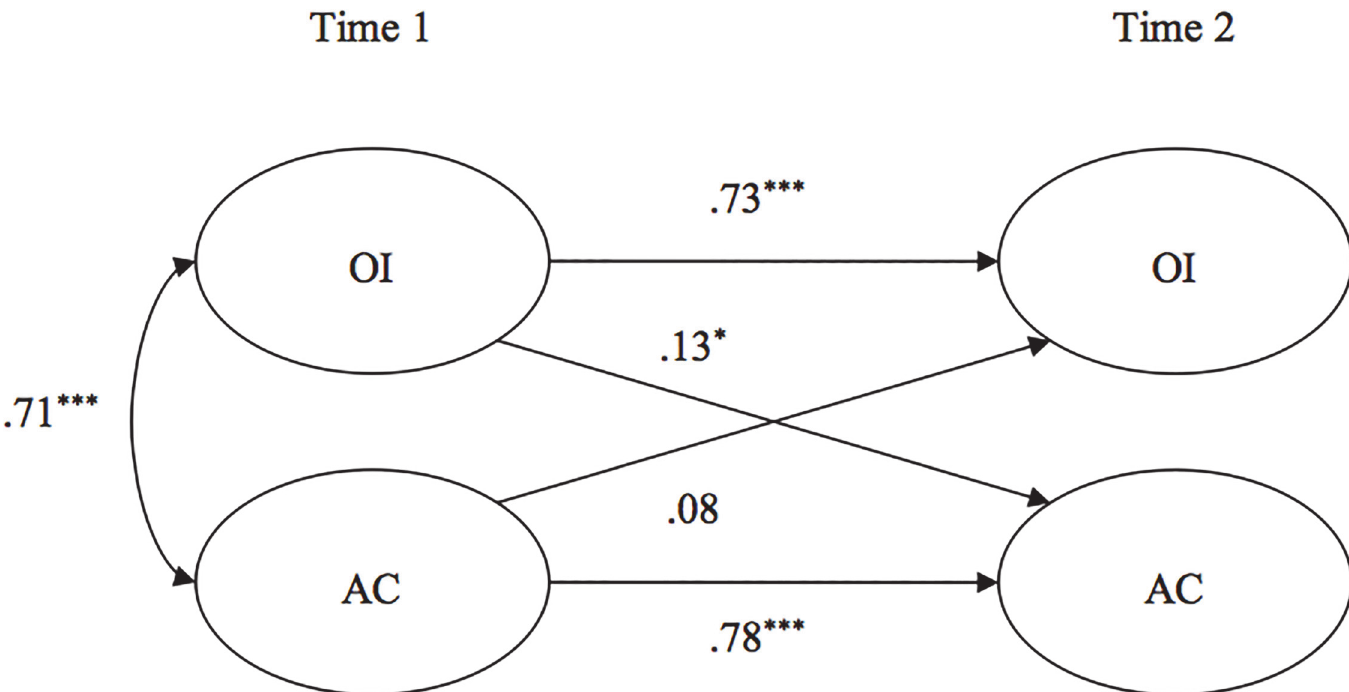
Fig 1. Study 1: Structural Equation Model of the Relationships Between Organizational Identification (OI) and Affective Organizational Commitment (AC) Over Time. * p < .05. ** p < .01. *** p <